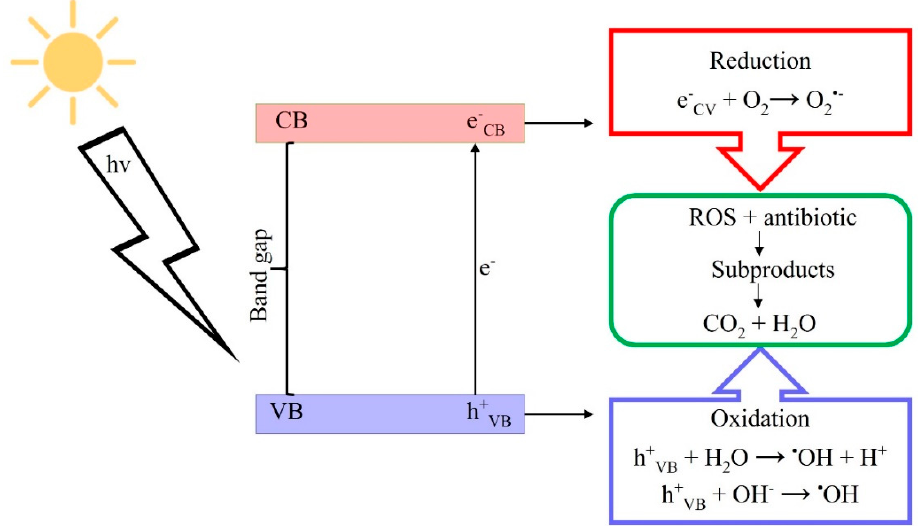
Figure 3. Representation of photocatalytic mechanism of heterogeneous photocatalysis conducted by semiconductors.